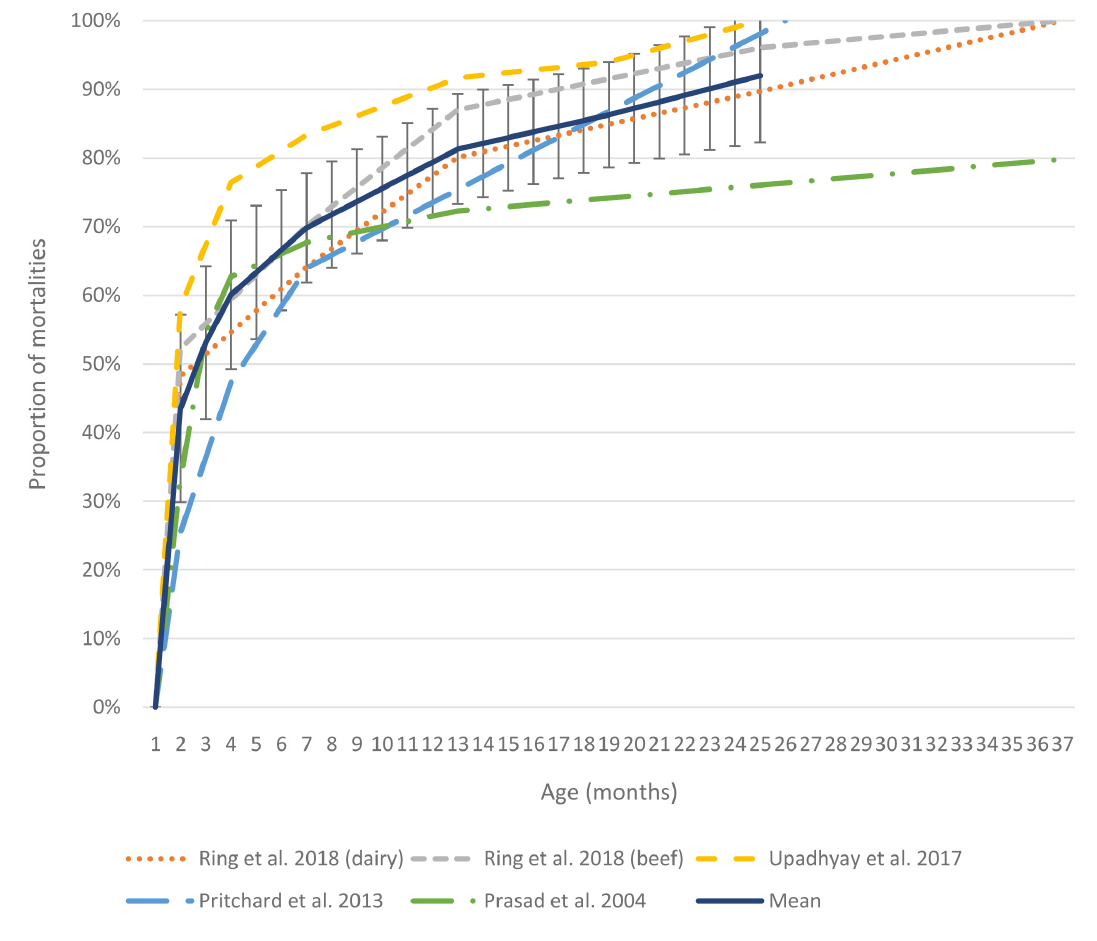
Figure 2. Cumulative mortality in cattle from birth to three years of age. Four included studies presented data on mortality distribution by age past 12 months of age. The black line shows the mean cumulative mortality with standard deviation